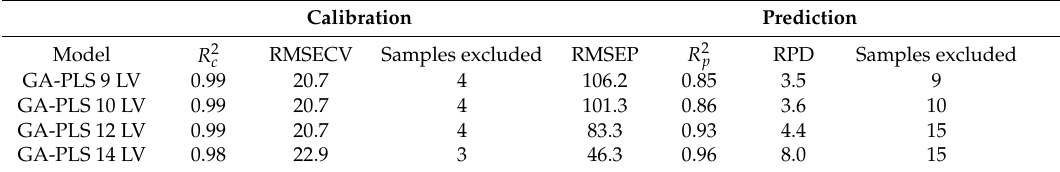
Table 3. Summary of statistics for the calibration and prediction sets for ascorbic acid (mg/100 g FW) in acerola fruit using FT-NIR z spectra for different GA-PLS (second derivative) models after outlier